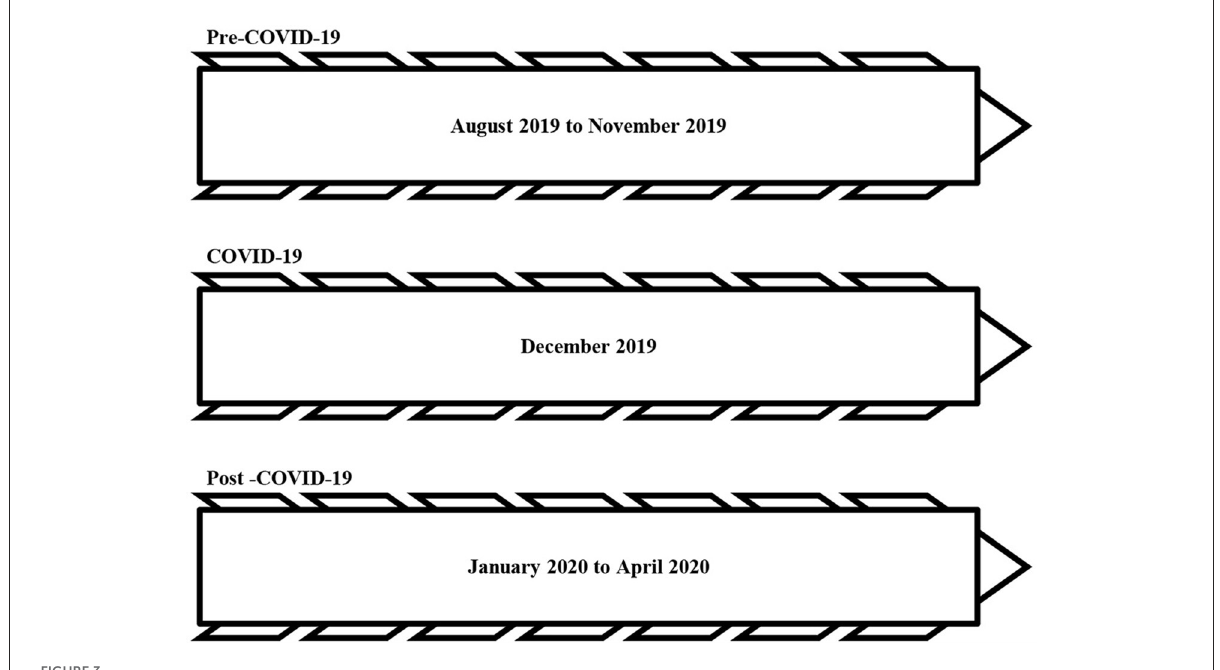
FIGURE3 Graphical representations of observation period. Source: